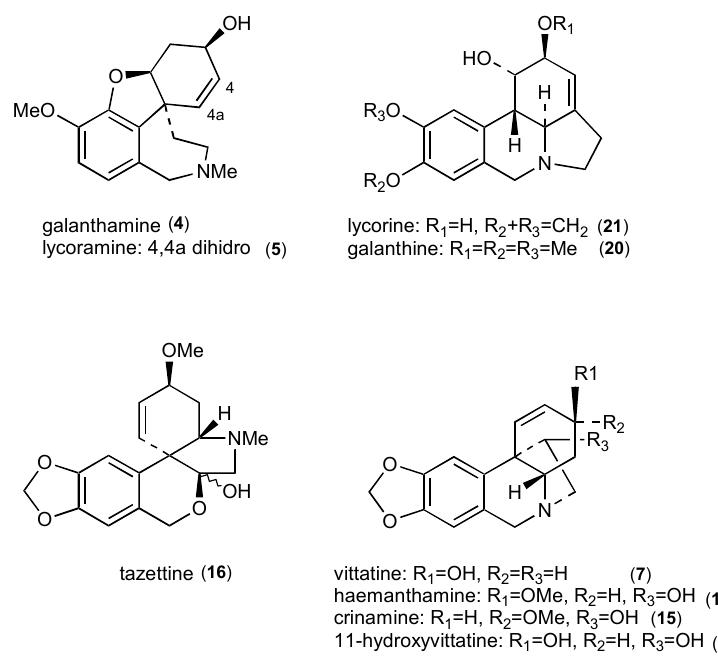
Figure 2. Main alkaloids in Wild Amaryllidaceae Species from Argentina.